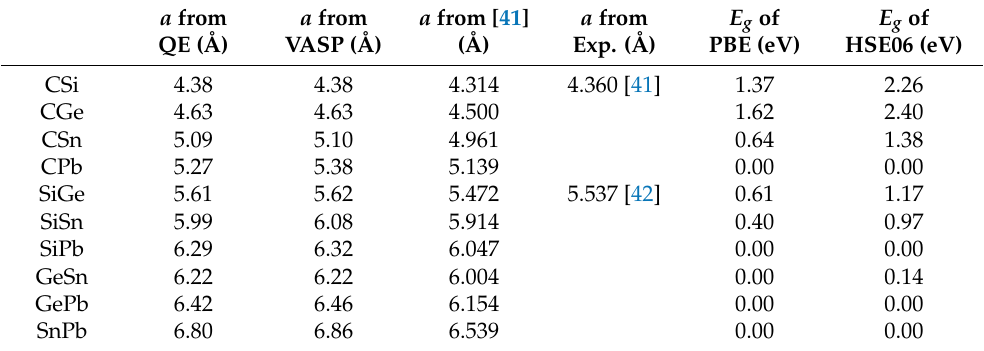
Table 1. The lattice parameters of group 14 alloys, and the band gaps E g from PBE and HSE06 calculation. Lattice parameters from another ab initio calculation [41] (Reprinted with permission from Ref. [41]. Copyright 2002, American Physical Society) and experimental data [41,42] are listed for